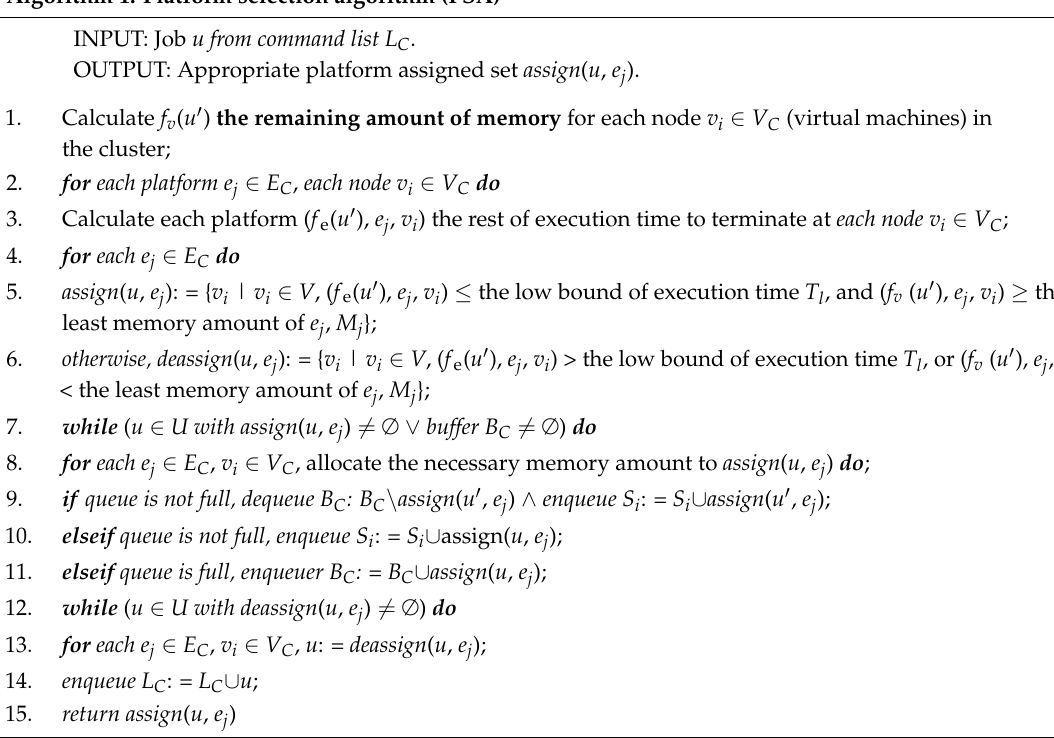
Algorithm 1. Platform selection algorithm